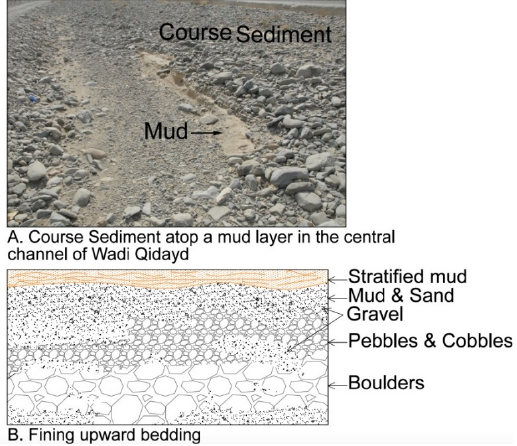
Figure 1. Channel sediments ( A ) and fining upward beds in the subsurface below the wadi channel ( B ).